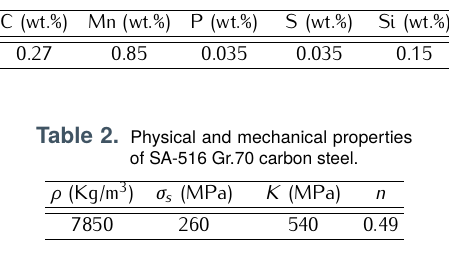
Table 1. Chemical composition of SA-516 Gr.70 carbon steel.